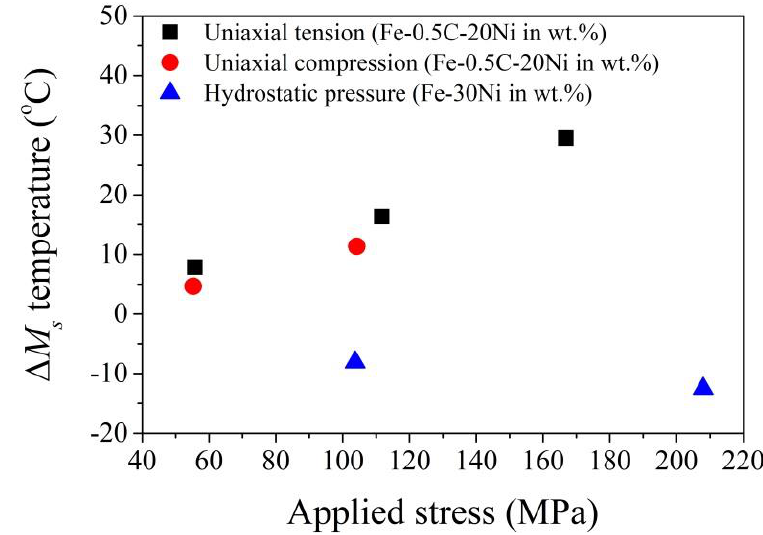
Figure 6. Effect of stress state on the change in M s temperature in different steel grades [87]. Figure 6. E ff ect of stress state on the change in M s temperature in di ff erent steel grades